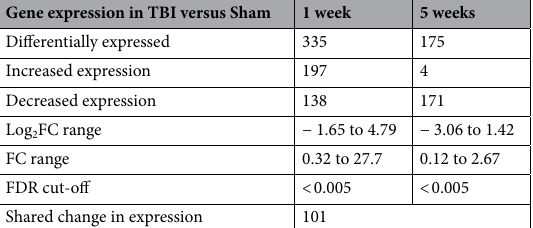
Gene expression in TBI versus Sham 1